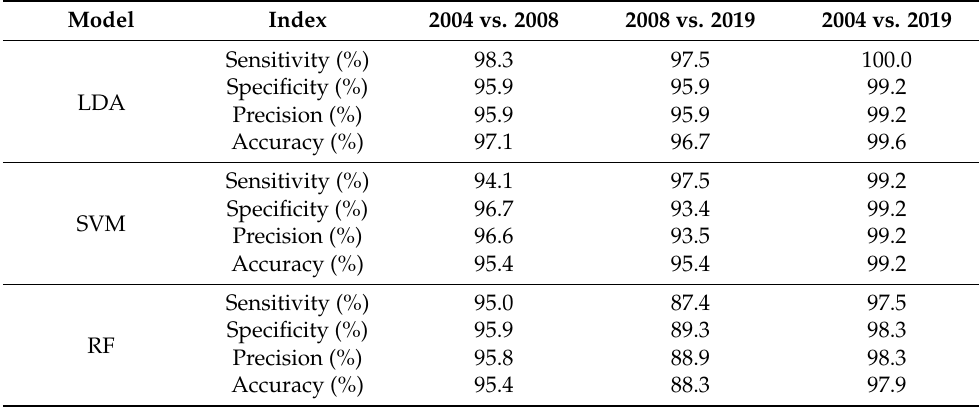
Table 4. Prediction of alfalfa seeds harvested in different years by LDA, SVM and RF